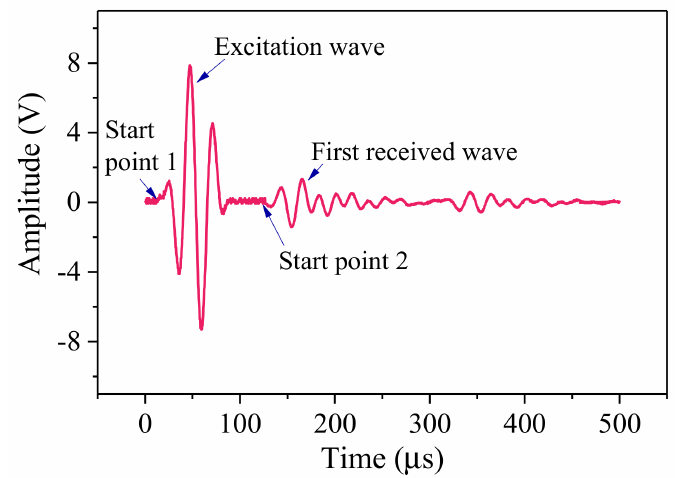
Figure 4. Pickup at the starting point and the time difference between the excitation and reception